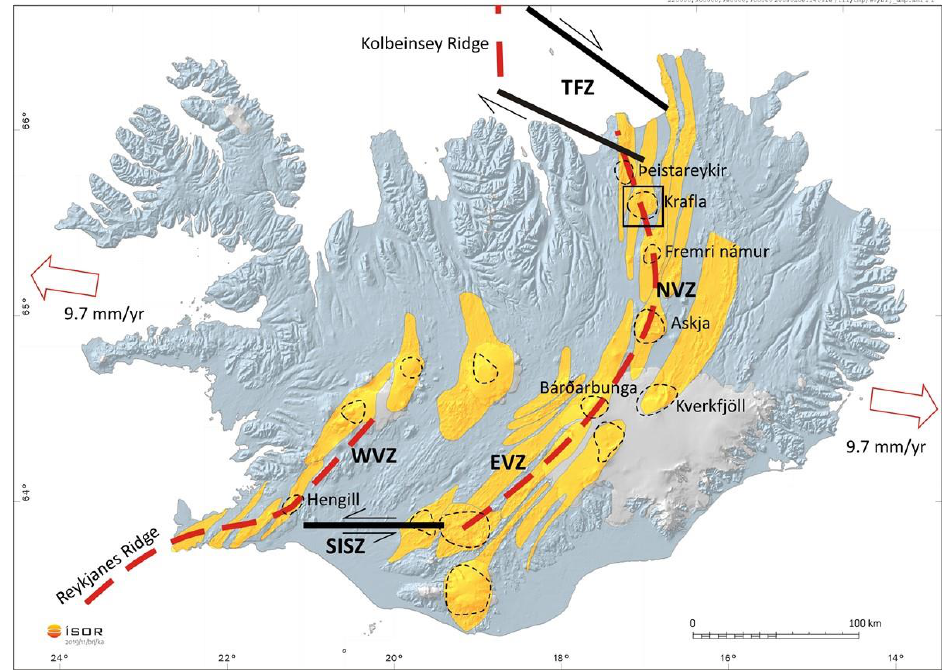
Figure 1. A simplified tectonic map of Iceland showing the location of Krafla (black square). Red broken lines represent spreading zones. WVZ is the Western Volcanic Zone, EVZ is the Eastern Volcanic Zone, NVZ is the Northern Volcanic Zone. SISZ is the South Iceland Seismic/Transform Zone and TFZ is the Tjörnes Fracture/Transform Zone. Thin black broken lines show central volcanoes and yellow coloured areas fissure swarms.